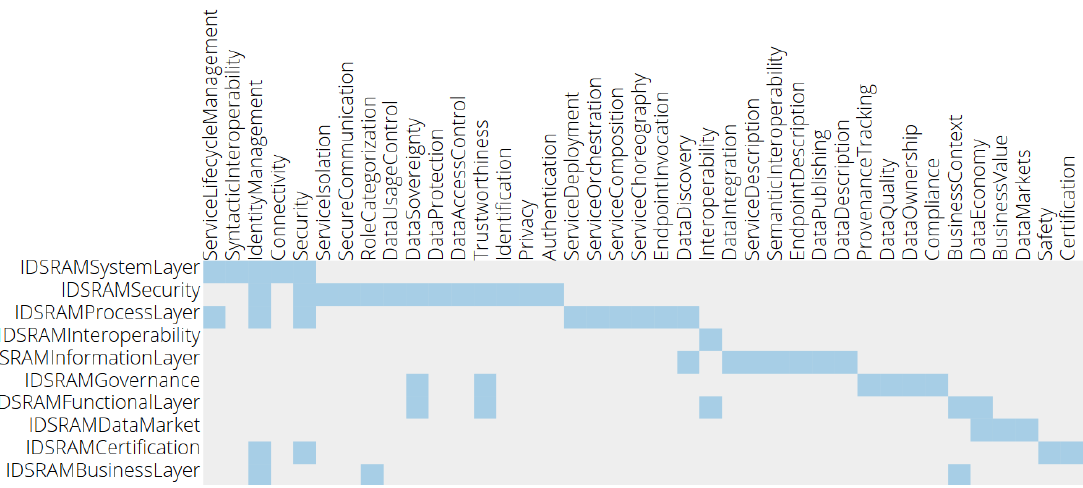
Figure 10. IDS Classifications with related concerns.